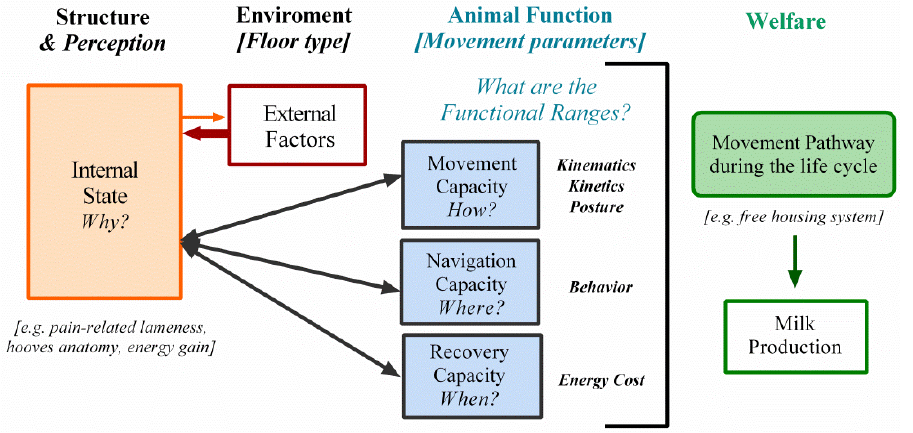
Figure 2. Bovine lameness was analyzed using a refurbished movement ecology concept methodology (modified from Nathan et al., 2008) [42]. This perspective allows a comprehensive view that can be assessed by functional parameters that contribute to bovine welfare, which aids production. Both the anatomical structure of the hoof and the animal’s psychological and physiological condition are defined as the internal state, which, in turn, is modified by, and introduces certain modifications to, the external factors. In particular, floor characteristics (an external factor) have an important effect on the cattle internal state (see thick arrow), exemplified here in the prevalence of pain-related lameness. Animal droppings can affect the surface frictional and soak status of the flooring, modifying the external factors to a lesser degree. Movement parameters (manifestations of the cow’s internal state) define the movement, navigation, and recovery capacities, and are indicators of function. To answer the question: why is the grass the best surface to prevent lameness? We explore the functional boundaries of each of these parameters according to the floor type. In sum total, along the animal’s life cycle, and as seen in the current study that focuses on housing systems, a movement pathway is determined, ensuring the animal’s welfare and conditioning its milk production capacity. Source: own creation inspired on the article cited.